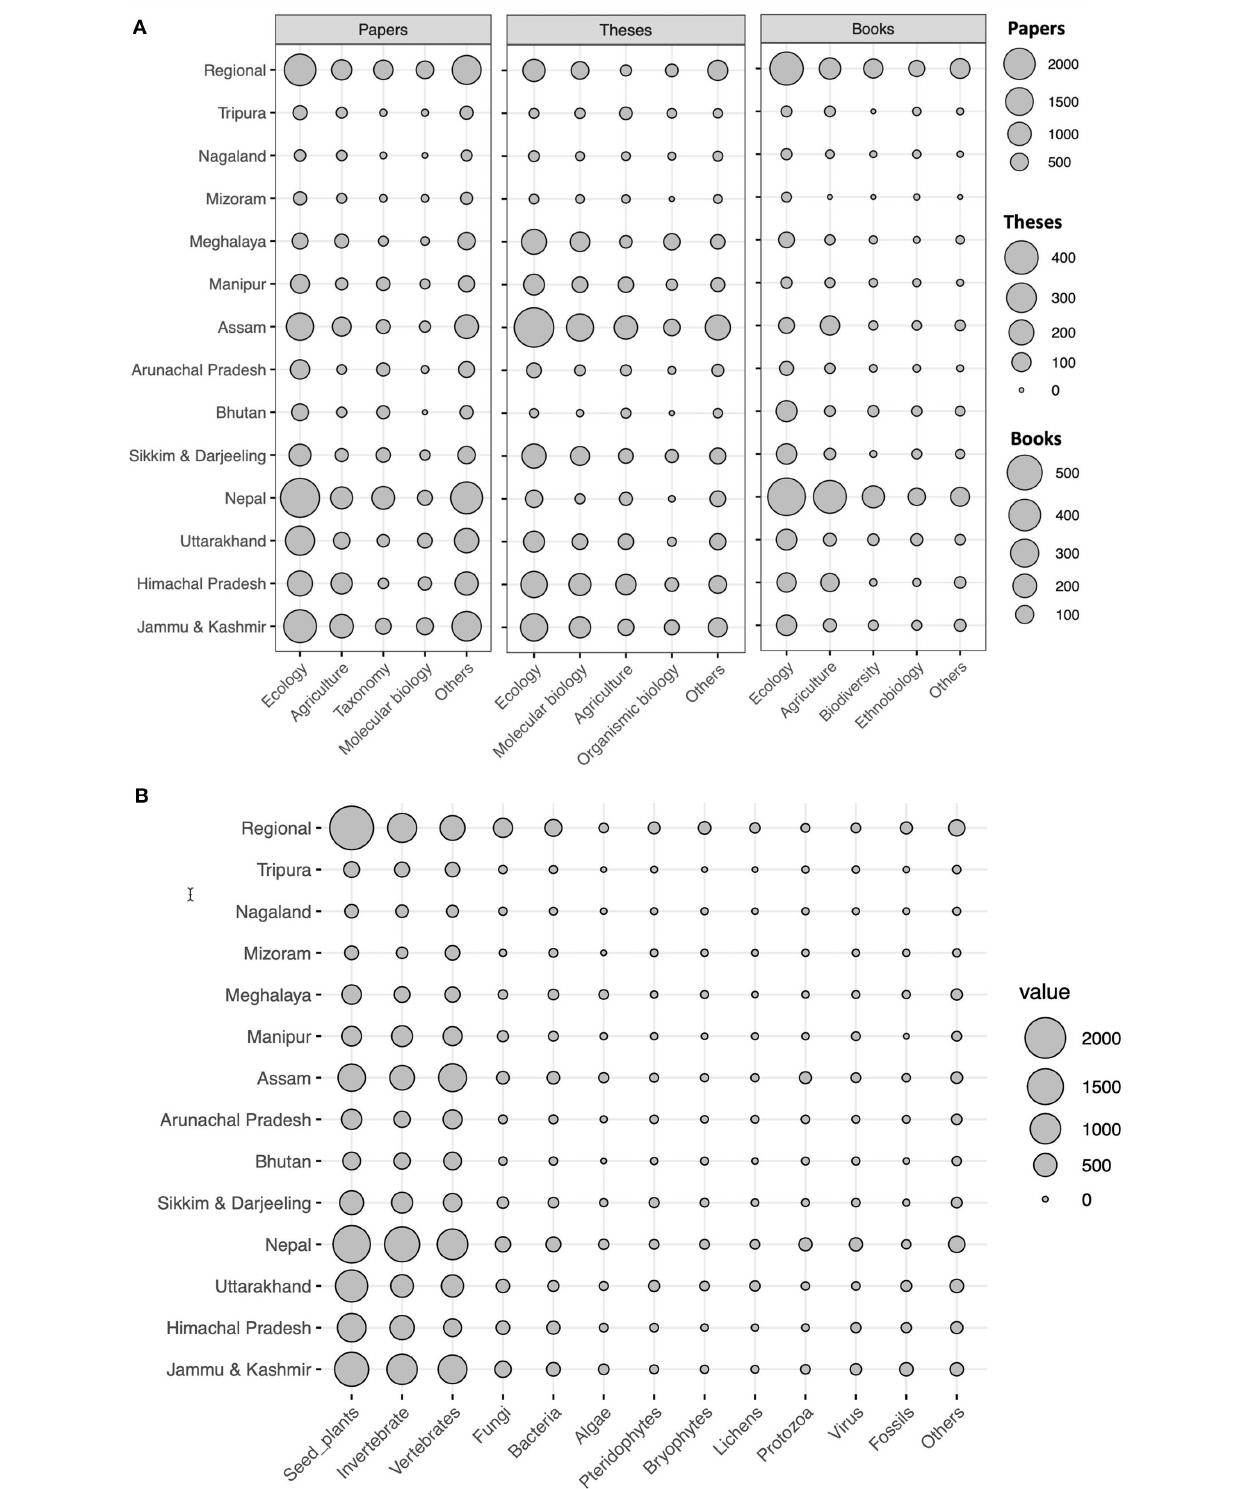
Frontiers in Ecology and Evolution |